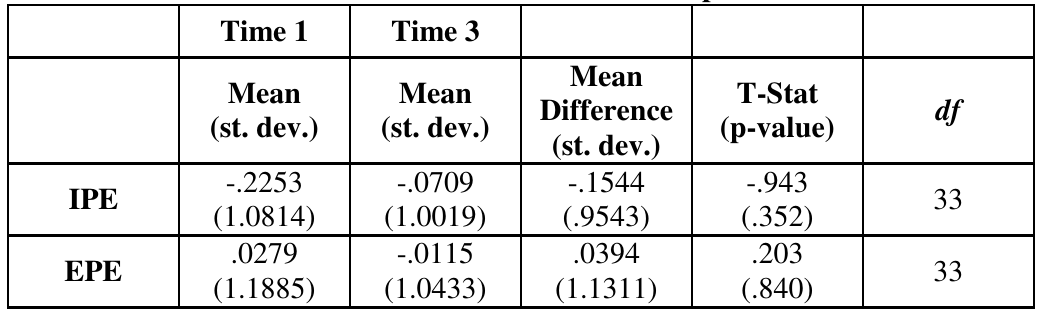
Table 12: T-Test Results - IPE and EPE for Non-Participants at Time 1 and Time